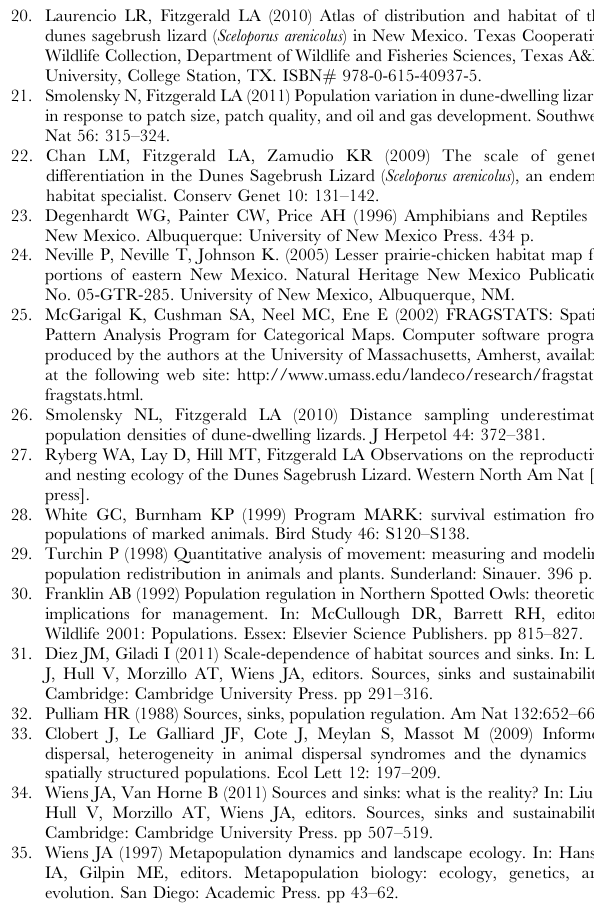
Table S8 Model ranking of Pradel mark–recapture models estimating apparent survival ( s ), recapture probability ( p ), and rate of population change ( l ) for S. arenicolus across 6 sites from